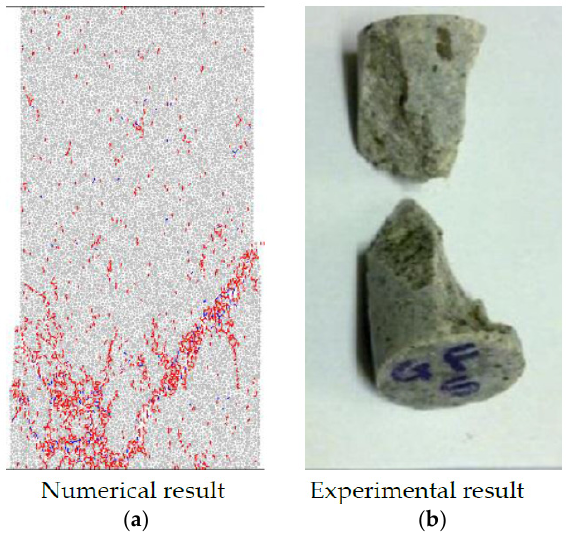
Figure 3. Comparison of ( a ) numerical and ( b ) experimental failure modes for the Strathbogie granite at room temperature under uniaxial compression [25].